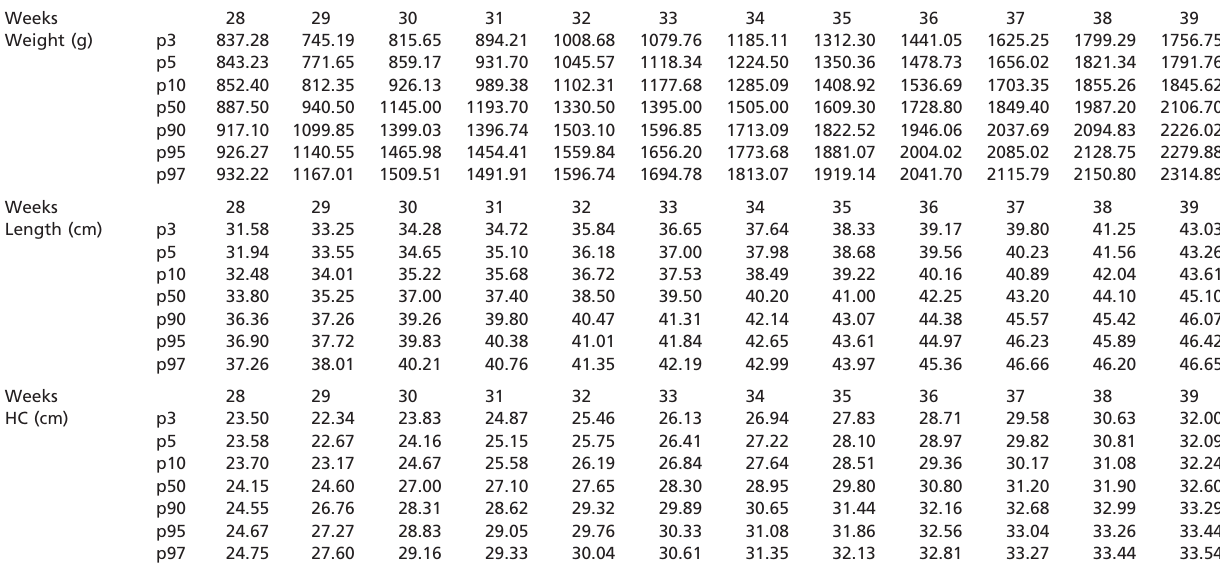
Table 4 - Evolution of Weight (w), Length (l) and Head Circumference (HC) percentiles (P3 to P97), according to the corrected gestational age, estimated through interpolation from the equation defined for each VLBWI of GII (n=